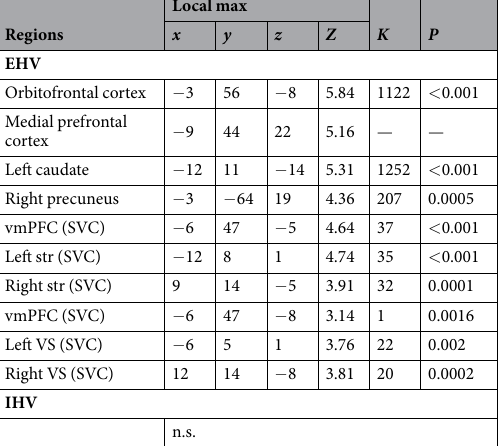
n.s. Table 2. Neural value representations. Brain areas showing positive correlation with the amount of money subjects were willing to pay during the purchasing task (explicit values) and perceptual tasks (task-irrelevant values). The uncorrected statistical threshold was p < 0.001, which was corrected to p < 0.05 using cluster size. Coordinates are reported in the stereotaxic space of the MNI. Abbreviations: vmPFC (ventromedial prefrontal cortex); VS (ventral striatum); SVC (small volume correction); EUV (explicit utilitarian values); IHV (task-irrelevant hedonic values); EHV (explicit hedonic values); IUV (task-irrelevant utilitarian values); MNI (Montreal Neurological Institute).